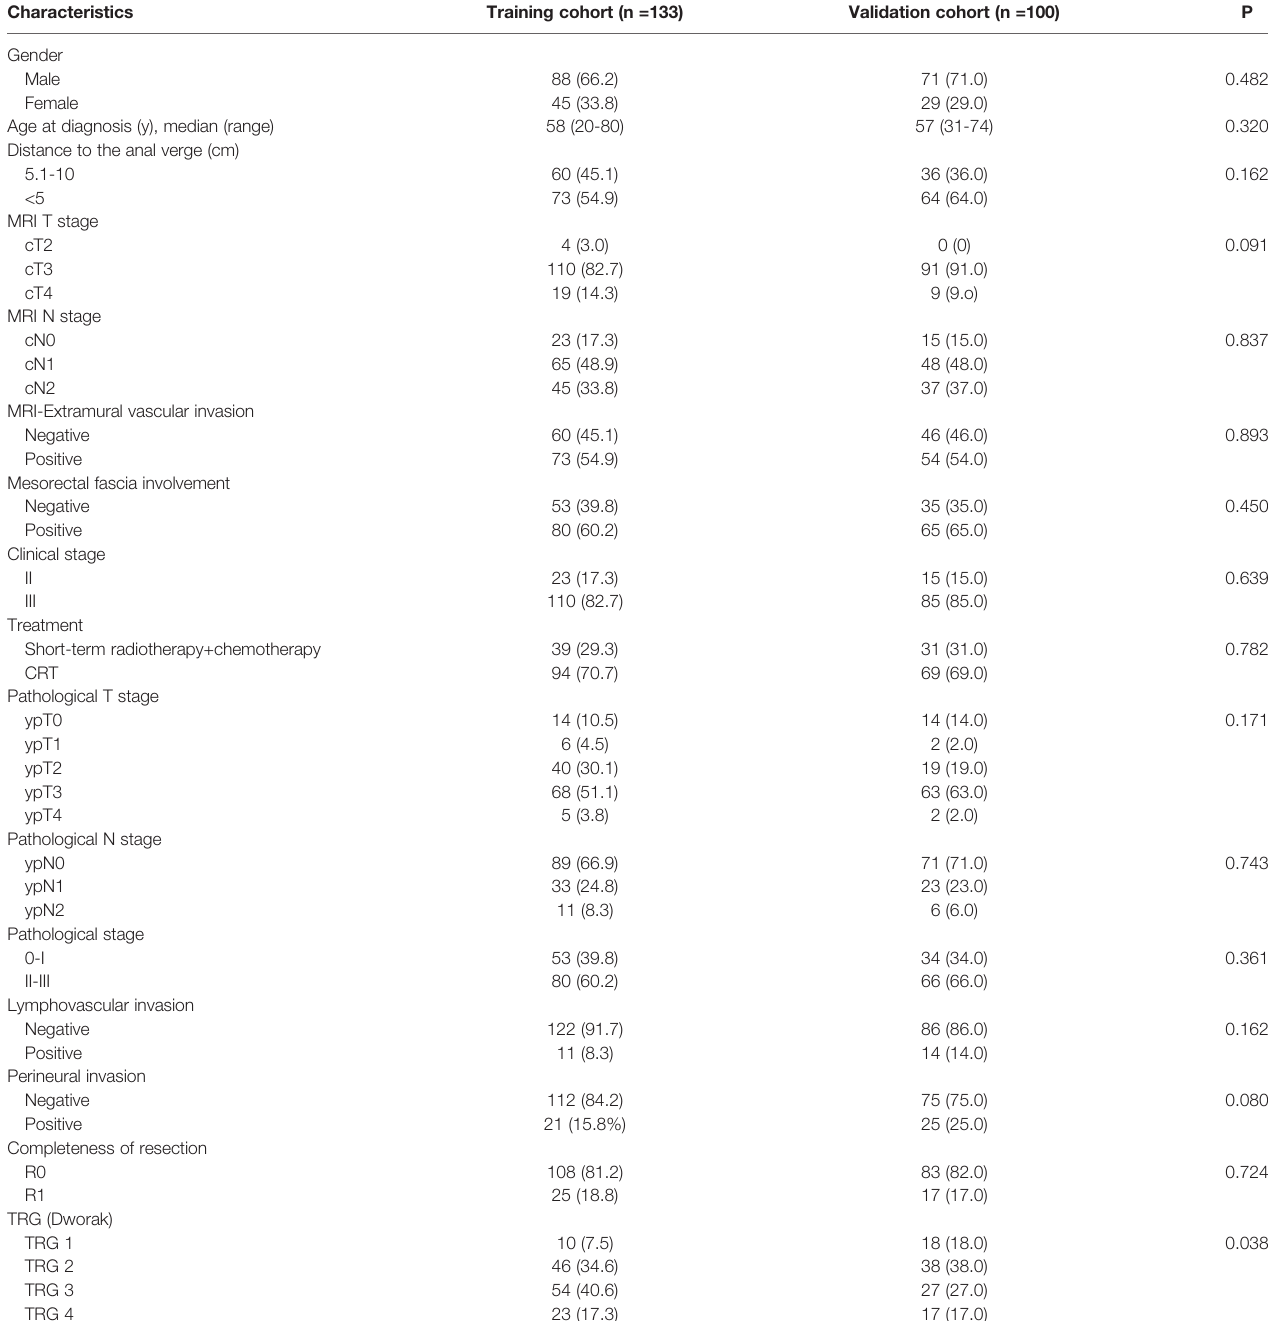
TABLE 1 | Characteristics of the patients in the training and validation